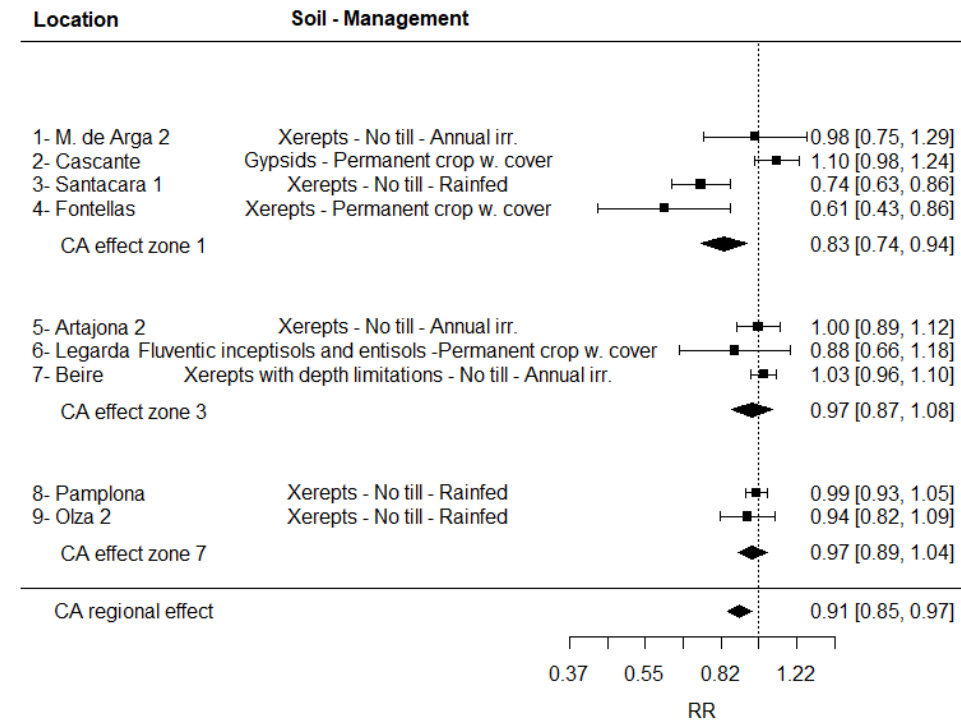
Figure 11. Response ratio (RR) of AWHC (0–30 cm) for the adaptive management strategy of conservation agriculture (CA). Zones correspond to those in Figure 1. The effect was considered significant when the 95% confidence interval (CI) of the RR did not overlap one ( α = 0.05). Soil and management column includes information about principal soil group, strategic management considered and irrigation regime in each group.